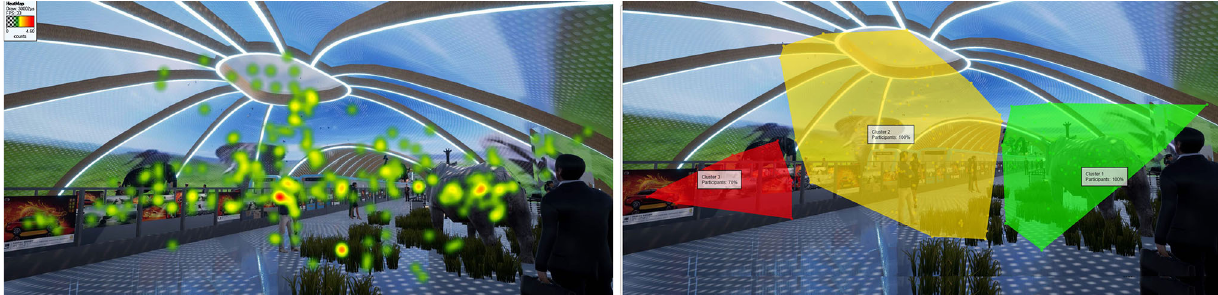
Fig. 6 Analysis of the proposed virtual zoo using VR with integrated ET (left: visual fixation heat map; right: areas of interest for ET analysis). By Jordan Sauer